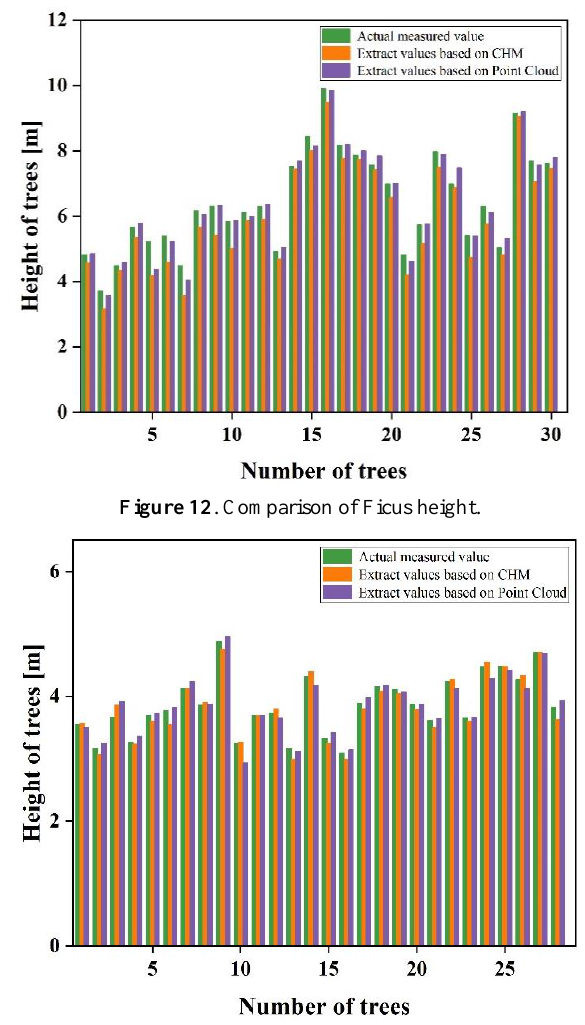
Figure 13 . Comparison of Osmanthus fragrans height.